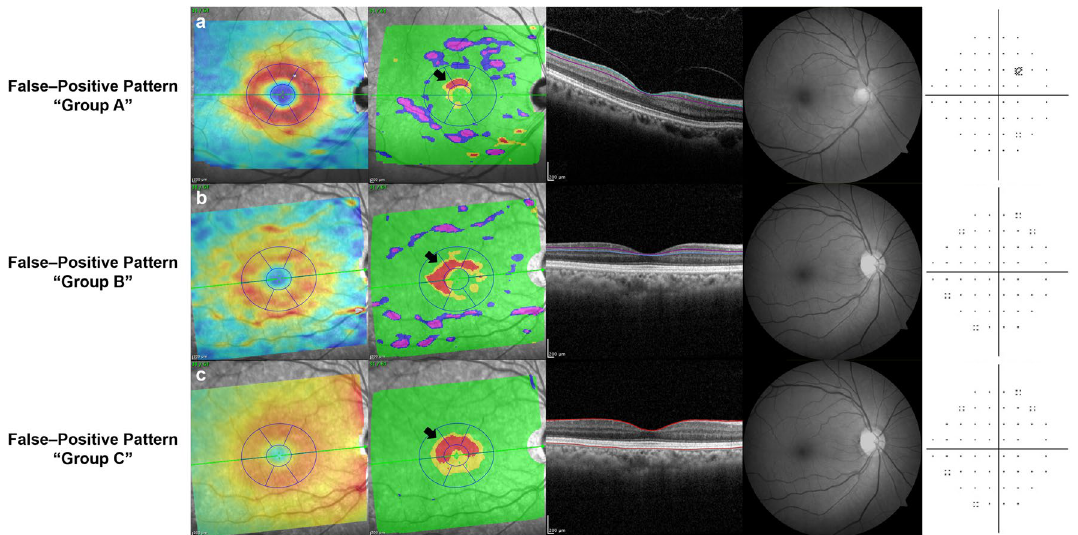
Figure 3. False-positive patterns on deviation maps of segmented macular layers on Spectralis OCT. Each labeled row ( a – c ), from left to right, consists of a thickness map, a deviation map, a corresponding B-scan with colored lines demarcating the segmented layer, red-free retinal nerve fiber layer (RNFL) photography and Humphrey (Carl Zeiss Meditec, Dublin, CA, USA) C24–2 visual field. ( a ) Healthy eye of 58-year-old female with pattern group A (island shape circumpassing less than 180° in area) on ganglion cell layer (GCL) deviation map. ( b ) Healthy eye of 66-year-old female with pattern group B (hook shape circumpassing more than 180° but less than 360° in area) on inner plexiform layer (IPL) deviation map. ( c ) Healthy eye of 66-year-old female with pattern group C (donut shape around inner annulus, circumpassing 360° in area) on retinal layer deviation